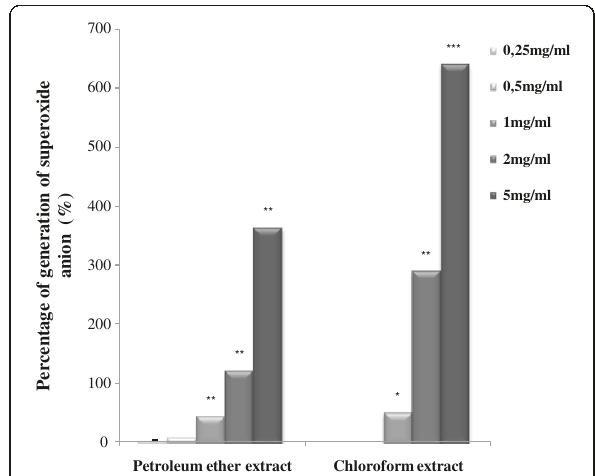
Figure 3 Pro-oxidant effect of petroleum ether and chloroform extracts towards superoxide anion generated by the non enzymatic system NBT/Riboflavine. Results were expressed as percentage of superoxide anion generation compared to the control. Values represent the mean±SD of three separate experiments. The statistical significance of results was evaluated by the Student ’ s t-test. *P<0.05, **P<0.01, ***P<0.001 means significant difference between control and treated